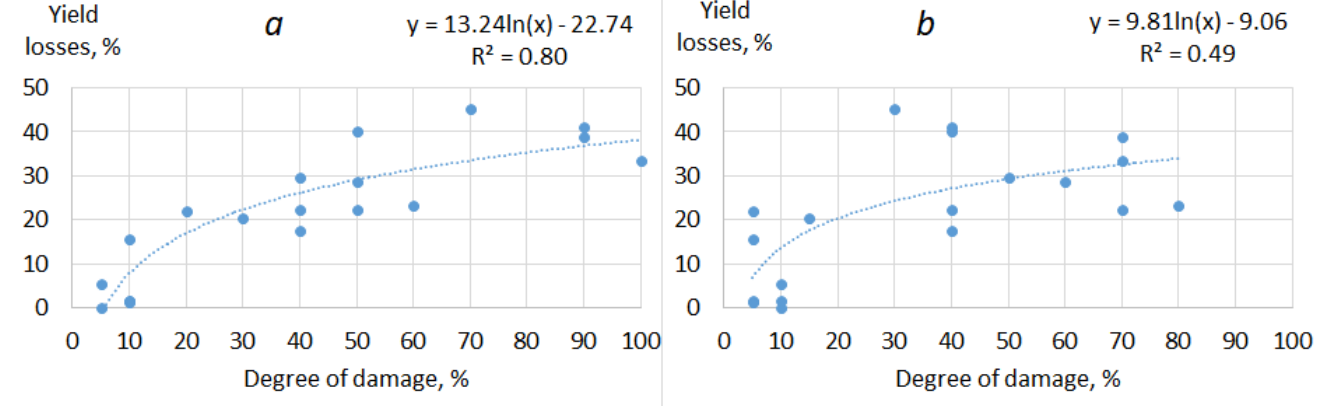
Figure 8. Regression relationship between the degree of septoriosis lesion and yield loss: ( a ) STB lesion of flag-leaf; ( b ) SNB lesion of ears. Every circle is an individual measurement from the plot with studied wheat cultivar.